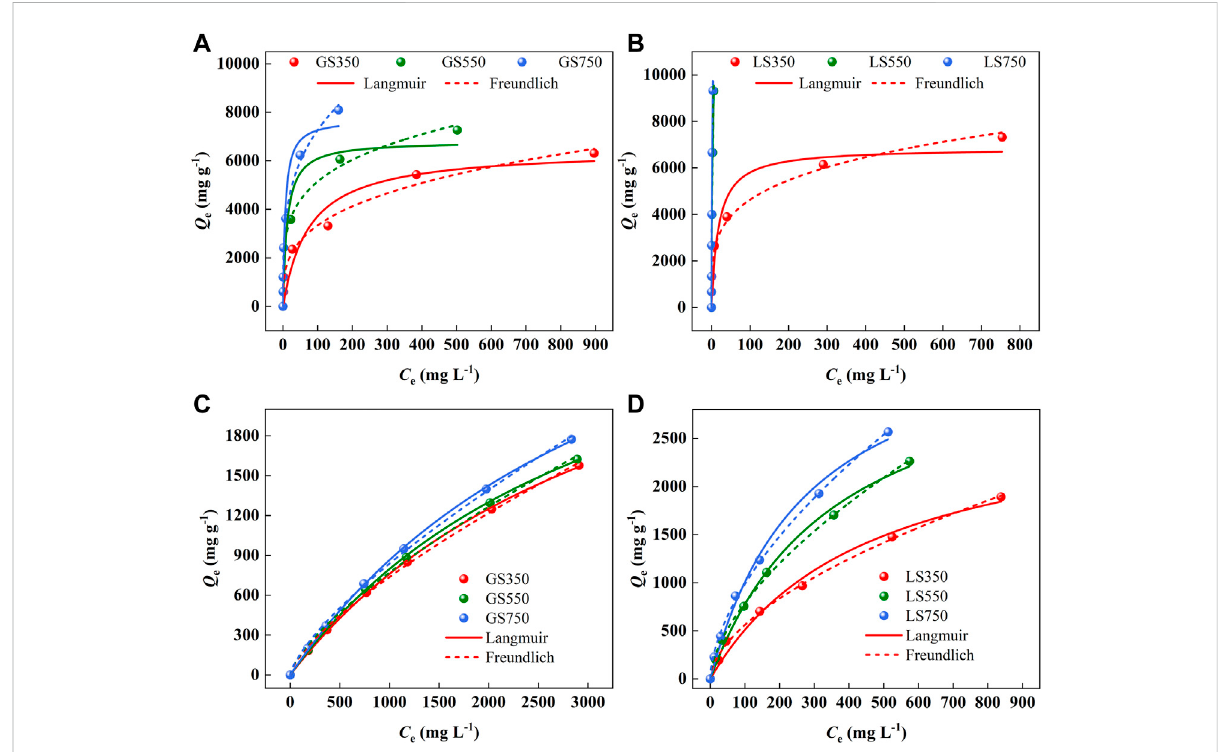
TheadsorptionisothermsofMG (A,B) andST (C,D) sorptionontoGSBCandLSBC.[Conditions]ForMGandST,initialpHof8and4,respectively, initial concentrations of 250 – 3,500 mg L − 1 , 24